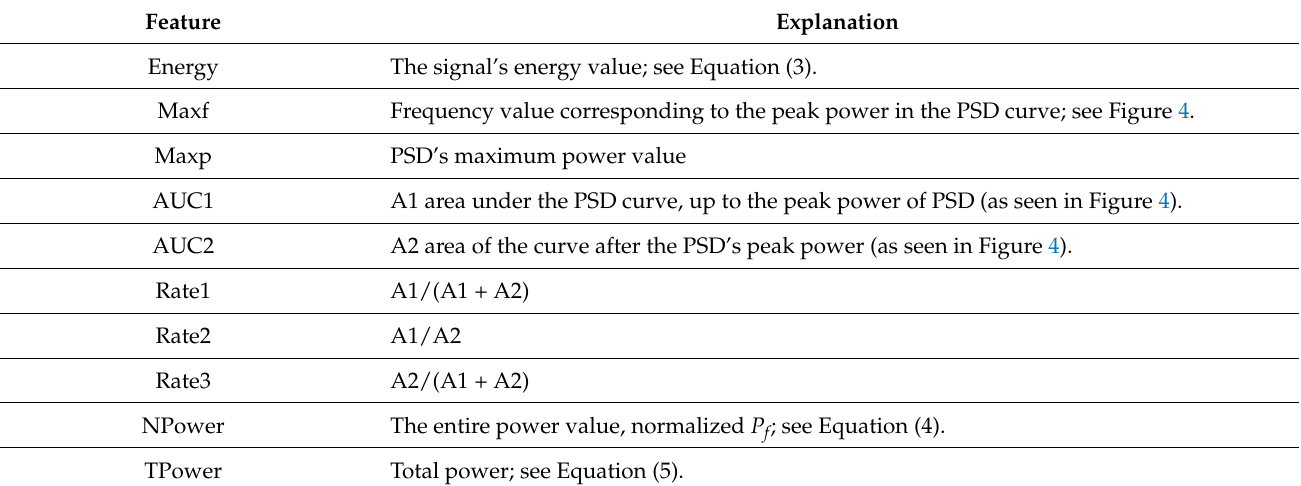
Table 2. List of 10 features extracted from each